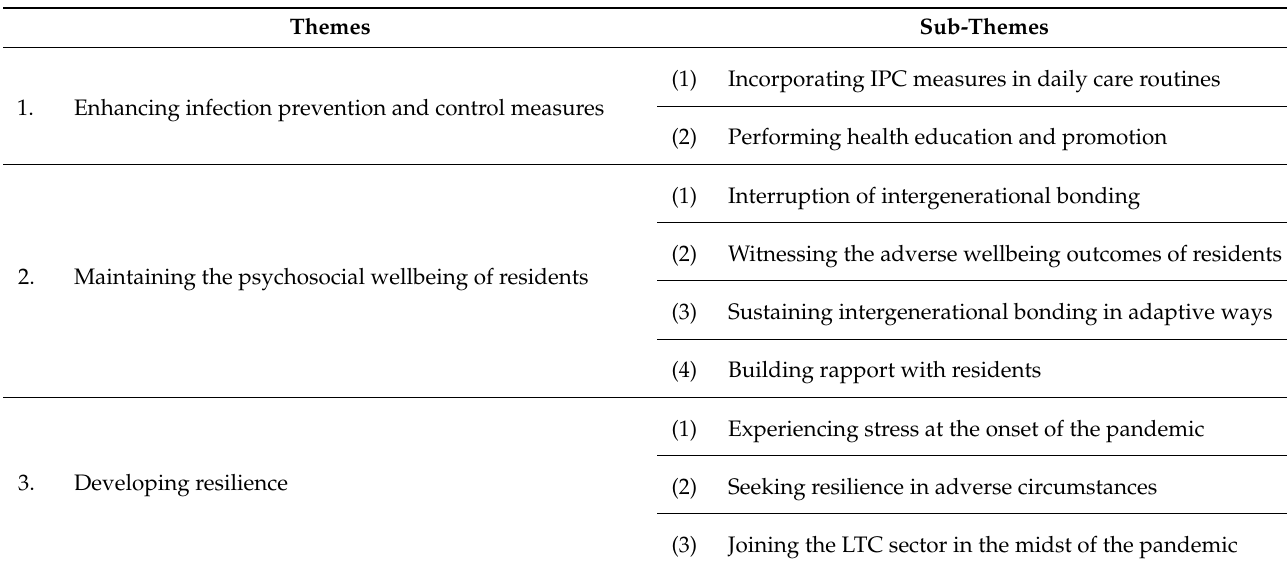
Table 3. Themes and sub-themes that emerged from the